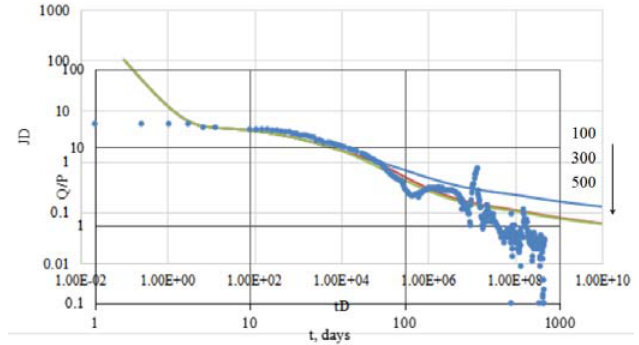
Figure 16. The results of type curves matching between data and proposed method.